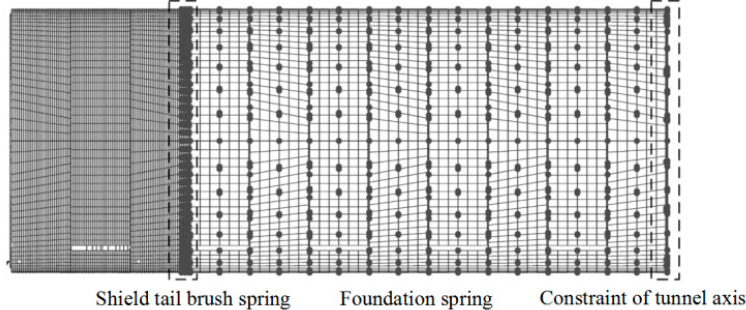
Figure 5. Boundary conditions.